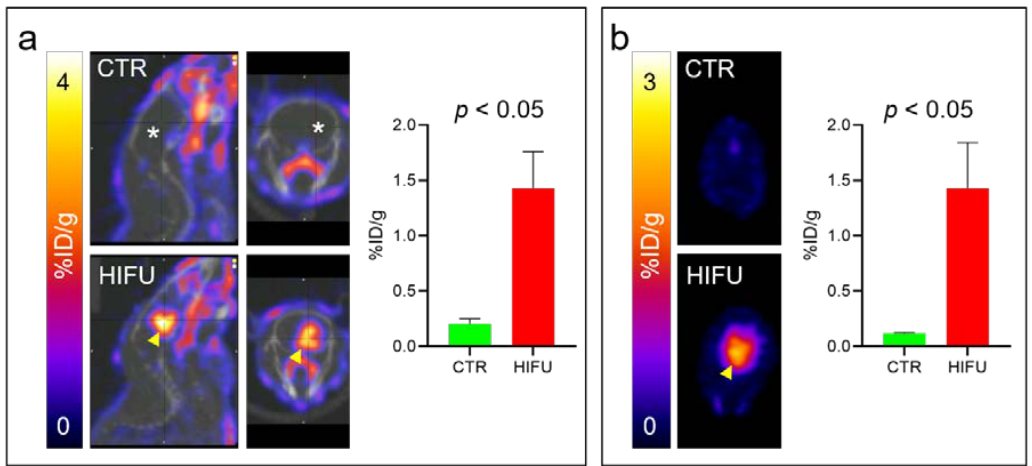
Figure 2. High-intensity focused ultrasound (HIFU) with microbubbles disrupts the blood–brain barrier (BBB) demonstrated with loco-regional brain uptake of [ 18 F]-(4S)-4-(3-[18F]-fluoropropyl)- L -glutamic acid ([ 18 F] FSPG) seen on positron emission tomography (PET) scan. ( a ) Control mice ( n = 4) or mice treated with HIFU with microbubbles ( n = 4) were injected i.v. with [ 18 F] FSPG. Thirty minutes post tracer injection, static PET images were obtained. Representative PET images for control (CTR, no HIFU) and HIFU-treated (HIFU) mice are shown together with quantification of PET signal. ( b ) Immediately after PET imaging, the brains of all mice were dissected, imaged, and quantified with PET to confirm in vivo PET signal. Asterisk, no [ 18 F] FSPG uptake detected in the brain of control mice. Arrowhead, [ 18 F] FSPG signal in the brain of mice after HIFU.